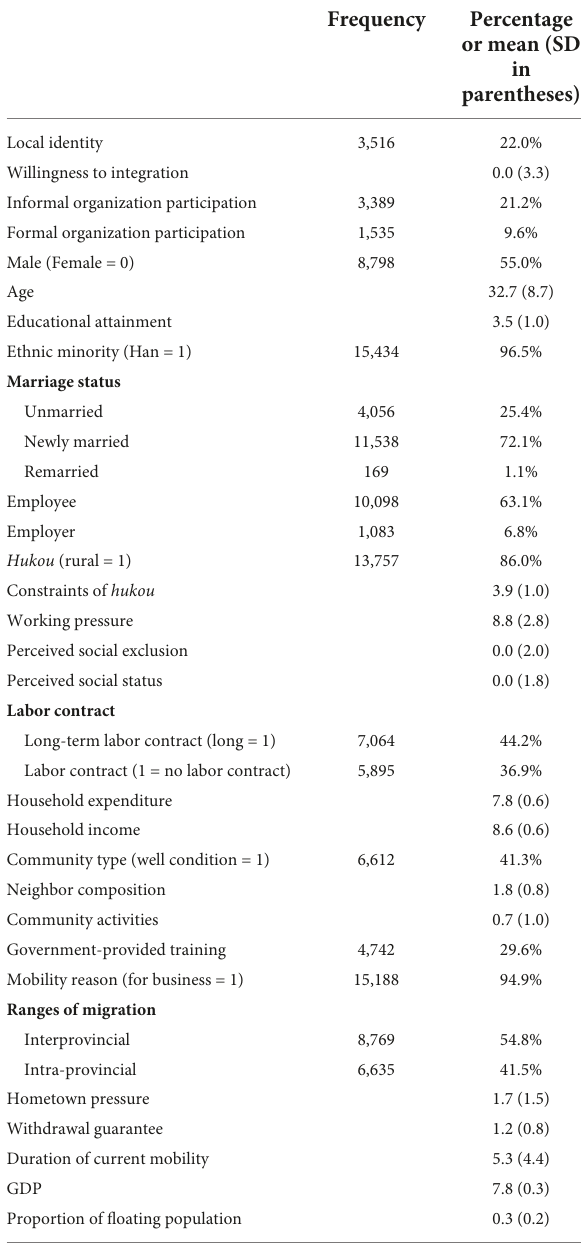
TABLE 1 Descriptive statistics of key